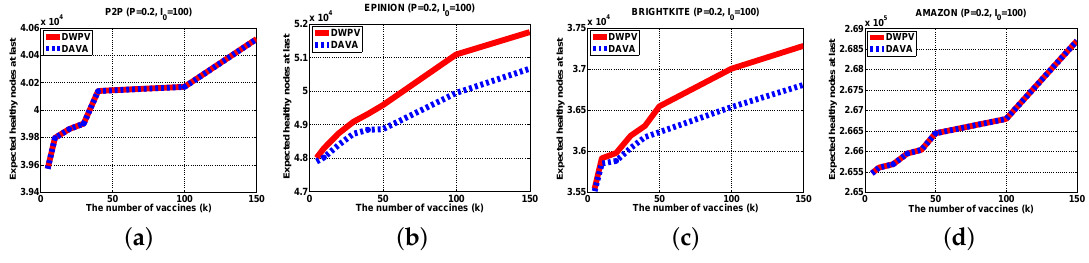
Figure 9. Experiments Results ( P = 0.2, I 0 = 100 ) . ( a ) P2P; ( b ) EPINION; ( c ) BRIGHTKITE; ( d )